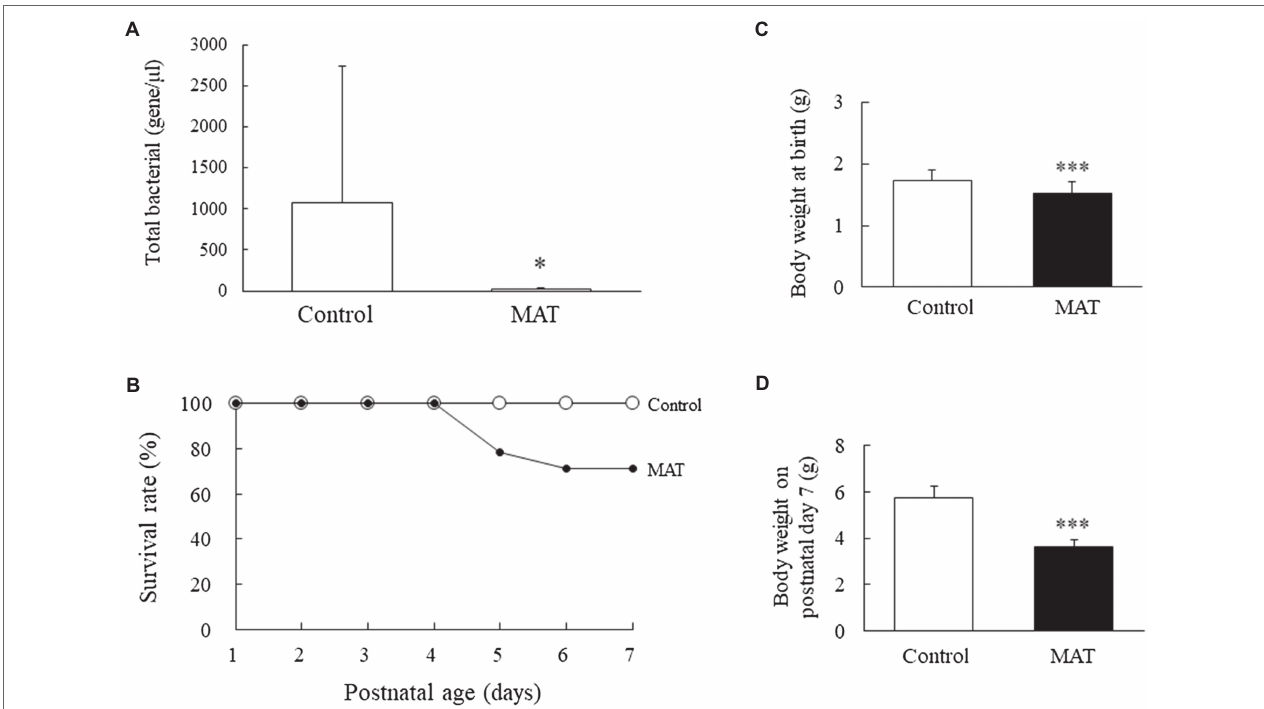
FIGURE 1 | Effects of MAT on (A) total intestinal commensal bacteria at birth, (B) survival rate, (C) body weight at birth, and (D) body weight on postnatal day 7. MAT significantly reduced the number of commensal bacteria in newborn mice compared with that in the control newborns. The survival rates were comparable between the mice born to control and antibiotic-treated dams. The mice born to the antibiotic-treated dams exhibited significantly lower body weights at birth and on postnatal day 7 than that of the mice born to the control dams. * p < 0.05; *** p < 0.001. MAT, maternal antibiotic